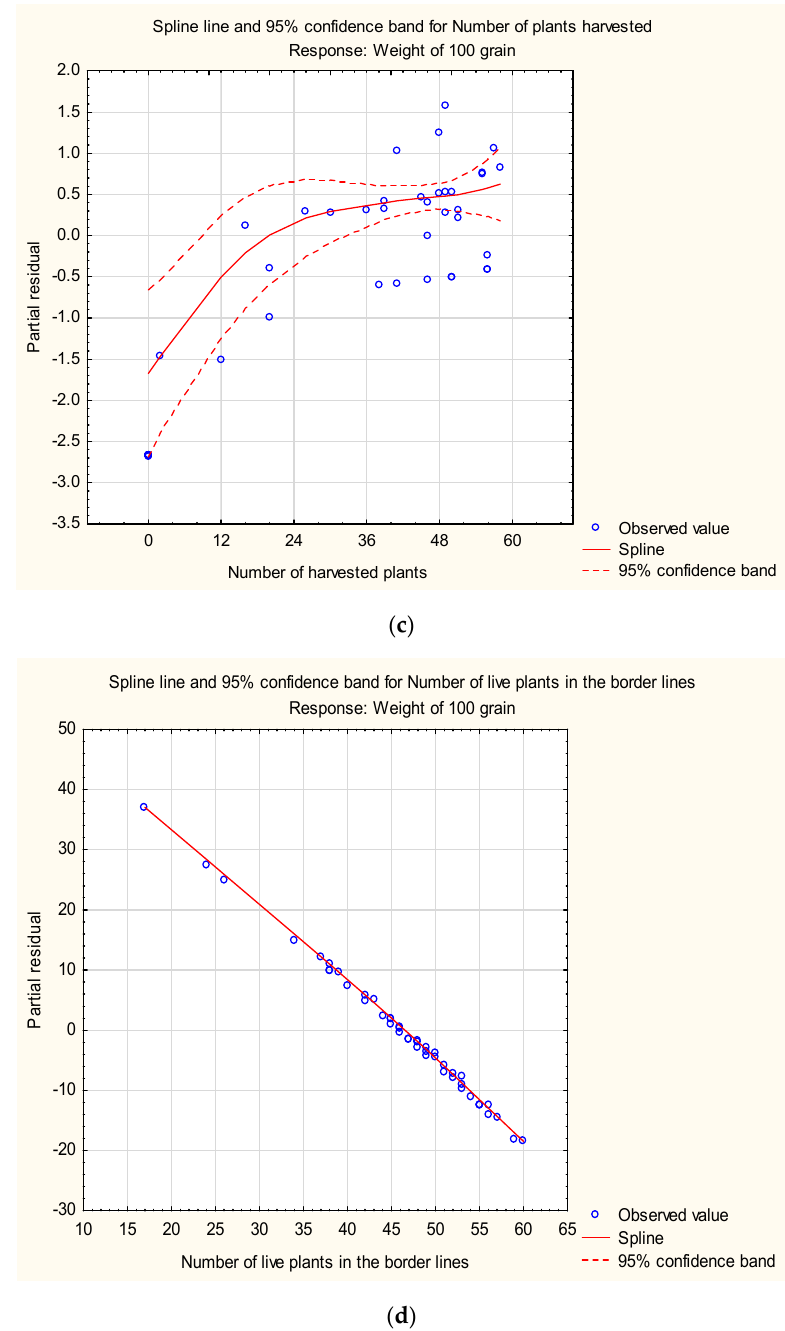
Figure 6. ( a ). GAM for germination rate as covariate and weight of 100 grain as response variable during abundance of Zonocerus variegates . ( b ). GAM for number of live plants on the central lines as covariate and weight of 100 grain as response variable during no occurrence of Zonocerus variegates . ( c ). GAM for number of harvested plants on the central lines as covariate and weight of 100 grain as response variable. ( d ). GAM for number of live plants in the border lines as covariate and weight of 100 grain as response variable.